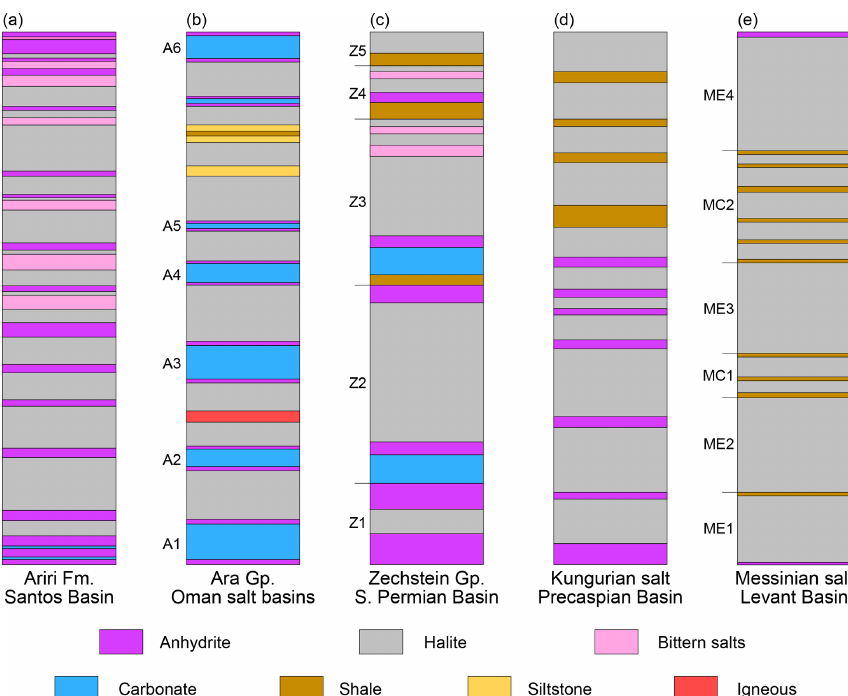
Figure 1. Representative stratigraphic columns through LESs: (a) upper Aptian Ariri Fm. from the offshore Santos Basin, Brazil (adapted from Gamboa et al., 2008); (b) uppermost Precambrian to Lower Cambrian Ara Gp. from the onshore Oman salt basins (adapted from Peters et al., 2003); (c) Upper Permian Zechstein Gp. from the Dutch sector of the Southern Permian Basin (adapted from Van Adrichem Boogaert and Kouwe, 1994); (d) Lower to Middle Permian Kungurian salt from the central portion of the Precaspian Basin, Kazakhstan (adapted from Gralla and Marsky, 2000); (e) uppermost Miocene Messinian evaporites from the Levant Basin, eastern Mediterranean (adapted from Feng et al., 2016, and Alexandros Konstantinou, personal communication, 2019) Although lateral variations in stratigraphy exist in every example, they are not shown here due to the difficulty of chronostratigraphic correlations in evaporite sequences (see Warren, 2016). Sections in panels (a) and (e) are from wells, whereas the others are more schematic; thicknesses and age spans are not equivalent in the different examples. Labels on the sides of panels (b) , (c) , and (e) are intrasalt stratal packages defined in the literature and referred to in the text and